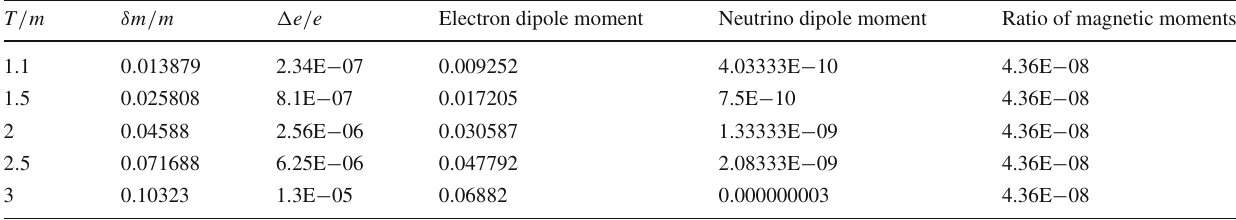
Table 1 Electron self-mass, charge, magnetic moment and neutrino magnetic moment have been evaluated for the same values of temper- atures in the units of the electron mass and below the coupling tem-